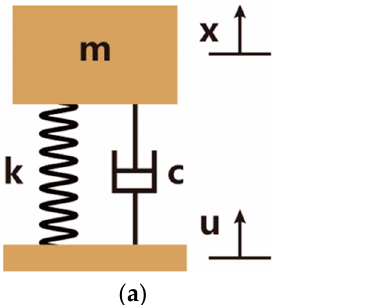
Figure 4. The equivalent model of the OSSS: ( a ) the acceleration transmissibility model; ( b ) the ac- celeration response model. The parameters 𝑘 and 𝑐 are the equivalent stiffness and damping co- efficient along the exciting direction, 𝑚 is the mass of the FOVH, 𝑥 is the displacement of the FOVH, 𝑢 is the displacement of the outer frame in the acceleration transmissibility model, and 𝐹 is the ambient exciting force provided by the signal in the acceleration response model.